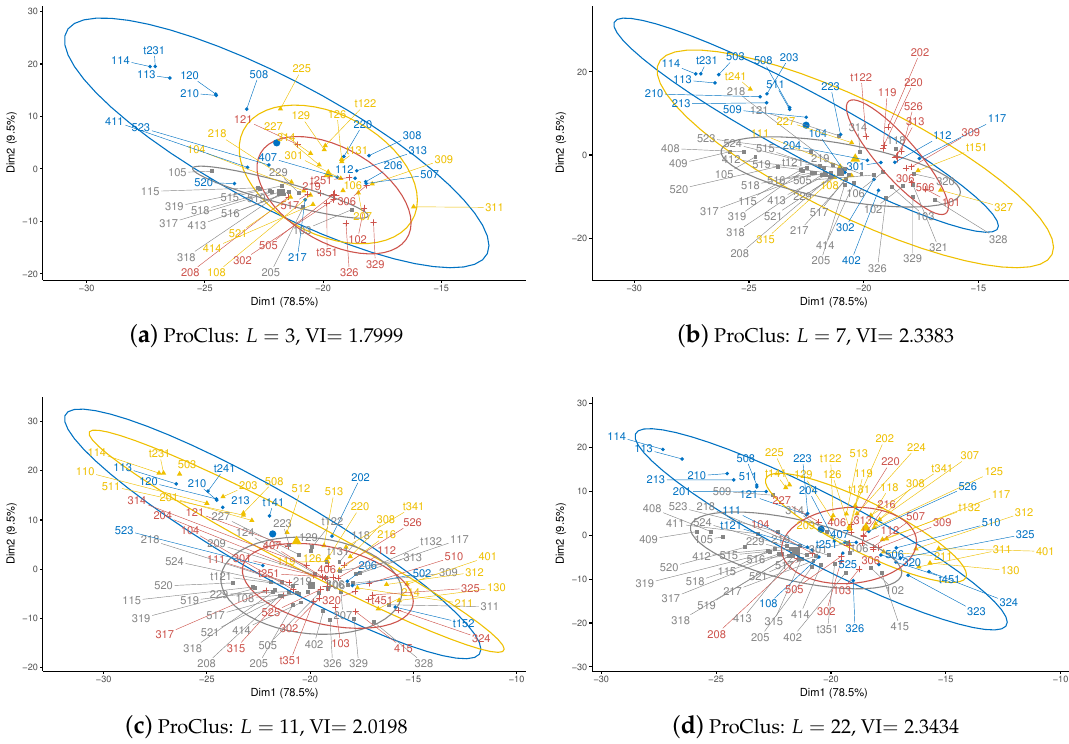
Figure 5. ProClus clustering on SFD-out data when K = 4, where cluster notations are consistent with Figure 3, non-overlapping labels denote station IDs, and VI is measured by comparison with alternative clustering produced by K-means ( K = 4) clusterer. Cluster plot is visualized using the factoextra package in